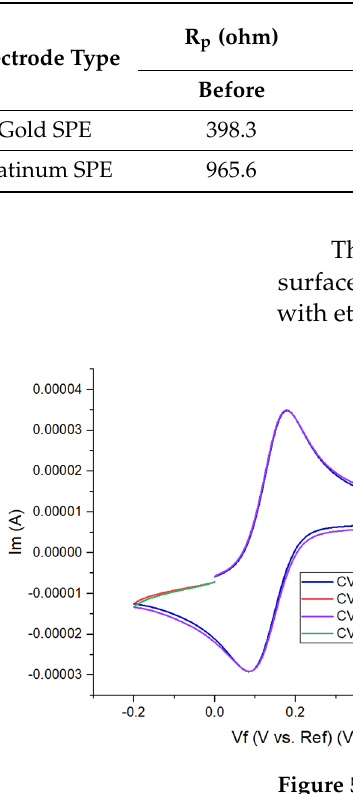
Figure 4. EIS of gold and platinum electrodes before and after cleaning with acetone: blue-EIS before cleaning; red-EIS after cleaning. Created with OriginPro.